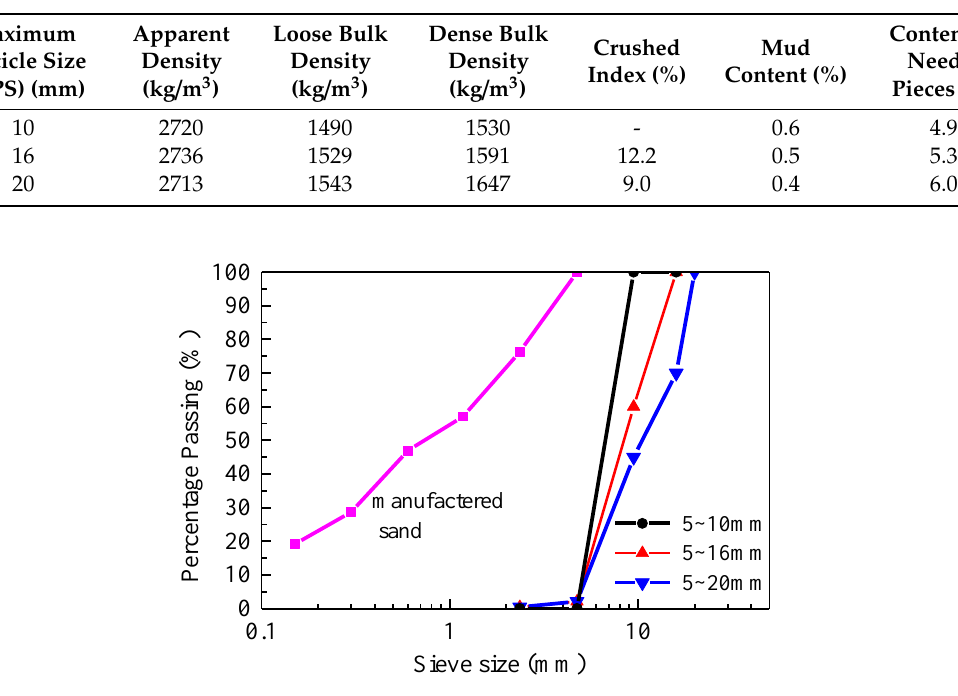
Figure 2. Particle size distributions of aggregate.